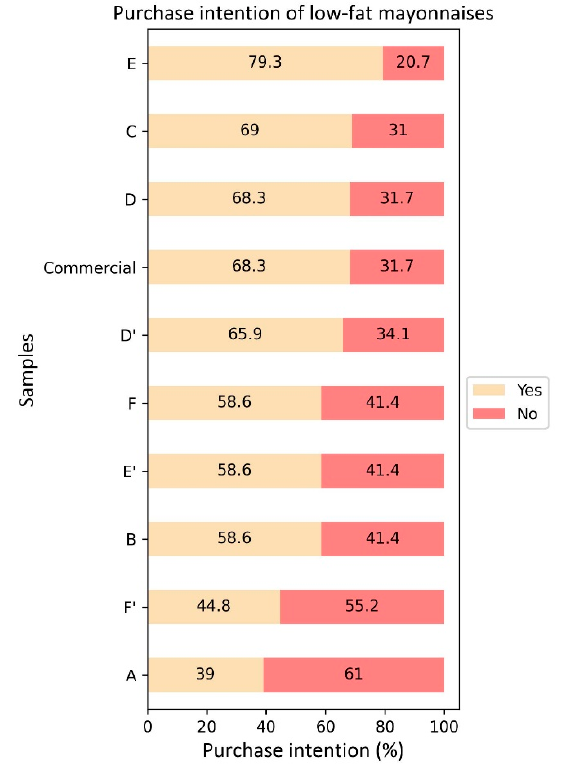
Figure 8. Purchase intention of different low-fat mayonnaise formulations.